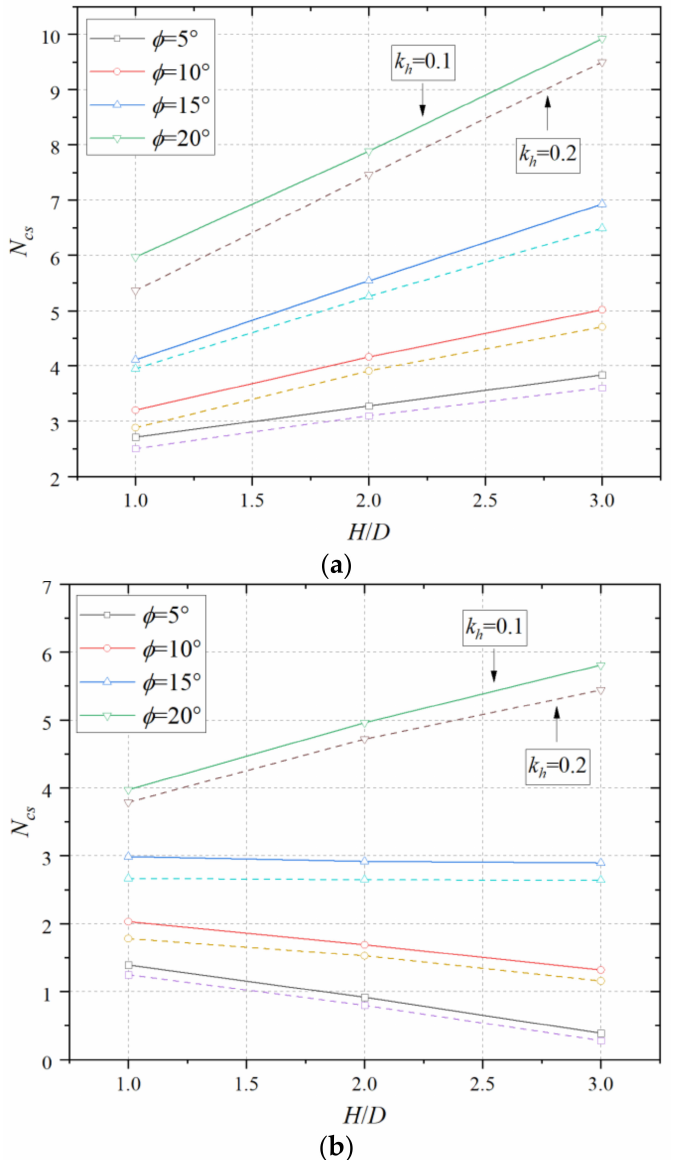
Figure 8. N cs - H / D curves with different ϕ and k h for ( a ) γ D / c = 0, S / D = 3; and ( b ) γ D / c = 1, S / D =